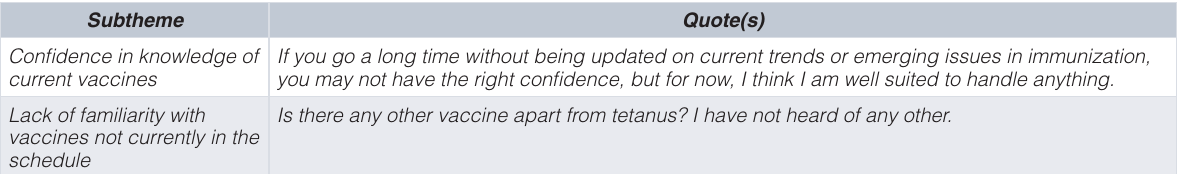
Table 4. Differences in provider knowledge about maternal